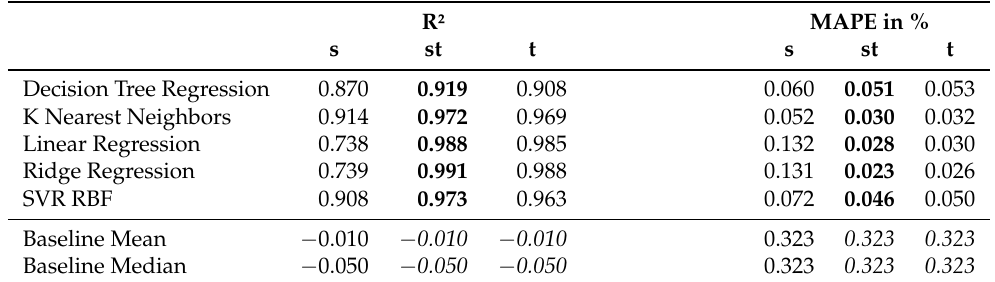
Table 8. Stacking Box Data Set II: results for Target Weight. The differences in comparisons of st or t vs. s were tested for significance, using the Wilcoxon signed-rank test ( α = 0.05): where the test did not confirm significant differences, the respective st or t values are printed in italic. The highest R 2 and the lowest MAPE are shown in bold for each algorithm.